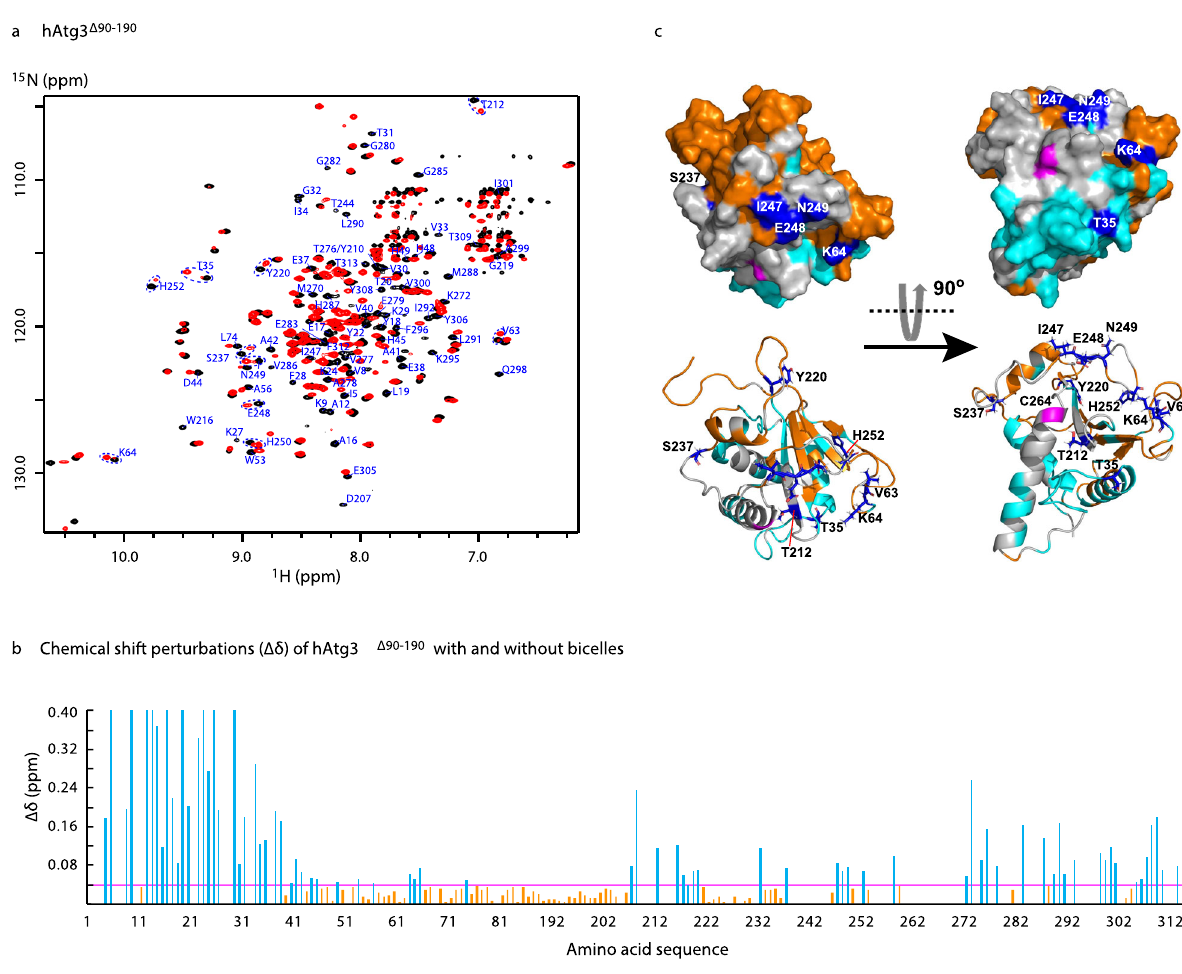
Fig. 5 Binding of hAtg3 Δ 90-190 to bicelles results in structural arrangements beyond its NT. a Overlay of 2 H, 15 N, 13 C-labeled hAtg3 Δ 90-190 TROSY spectra acquired on a Bruker 600MHz spectrometer at 25 °C, pH 7.5 in the absence (black) and presence (red) of bicelles (DMPC:DMPG:DHPC = 4:1:20, molar ratio). b Plots of hAtg3 Δ 90-190 15 N and 1 H chemical shift perturbations (CSPs, Δ δ ) upon interaction with bicelles against residue numbers. ffiffiffiffiffiffiffiffiffiffiffiffiffiffiffiffiffiffiffiffiffiffiffiffiffiffiffiffiffiffiffiffiffi q Δ δ ¼ 0 : 5 (cid:2) fð δ N Þ 2 þ δ 2 g , δ H and δ N represent the changes in 1 H and 15 N chemical shifts upon interacting with bicelles, respectively. c Surface and ribbon H 5 representations of a hAtg3 structural model with perturbed residues ( Δ δ ≥ 0.04 ppm) colored cyan and unperturbed residues ( Δ δ < 0.04 ppm) colored orange. The active site C264 is highlighted in magenta and unassigned residues are colored white. Some resonances displaying large CSPs are circled in ( a ) and their corresponding residues are colored blue in ( c